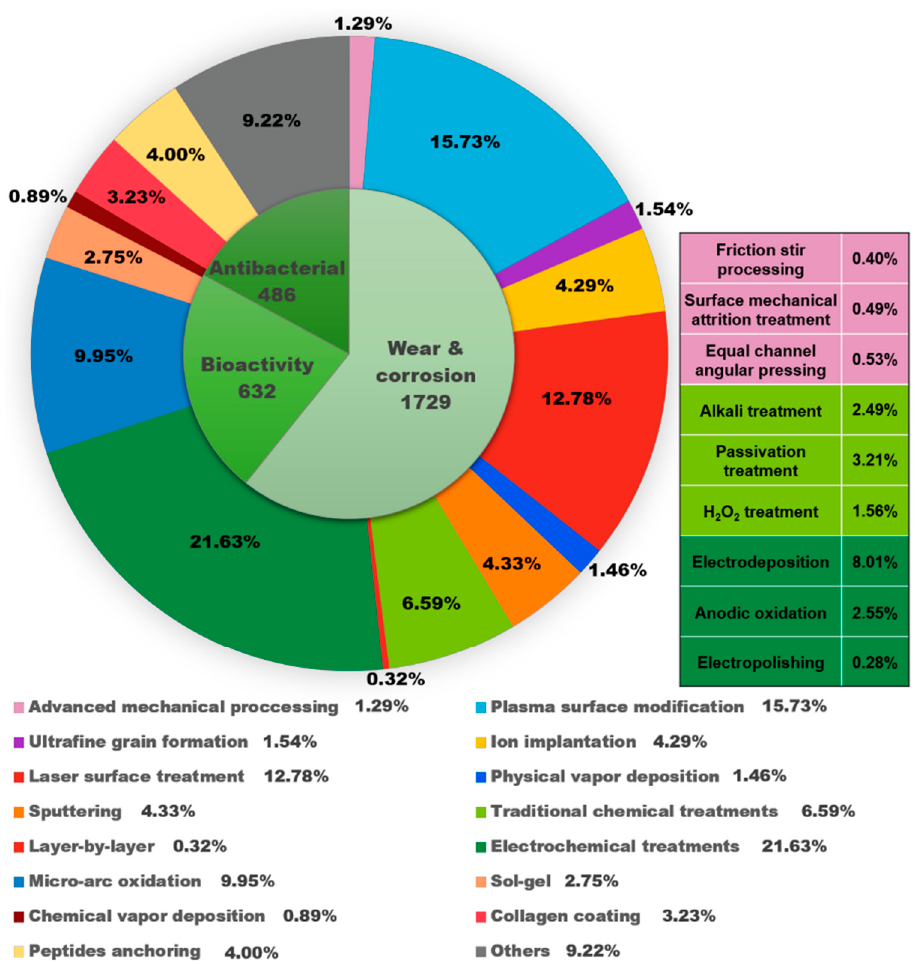
Figure 9. Diagrammatic representation of the analytical findings from three-year-old Web of Science Core Collection academic publications on the subject of surface modification of Ti alloys. Reprinted with permission from [80]. Copyright 2021 MDPI. Distributed under Creative Commons Attribution-based license (CCBY 4.0.).